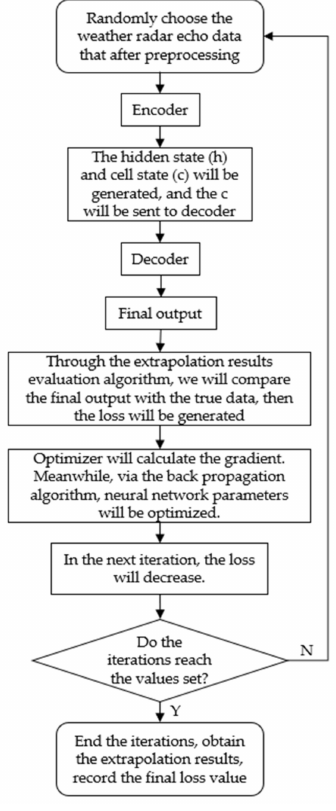
Figure 6. Flowchart of the proposed method by this